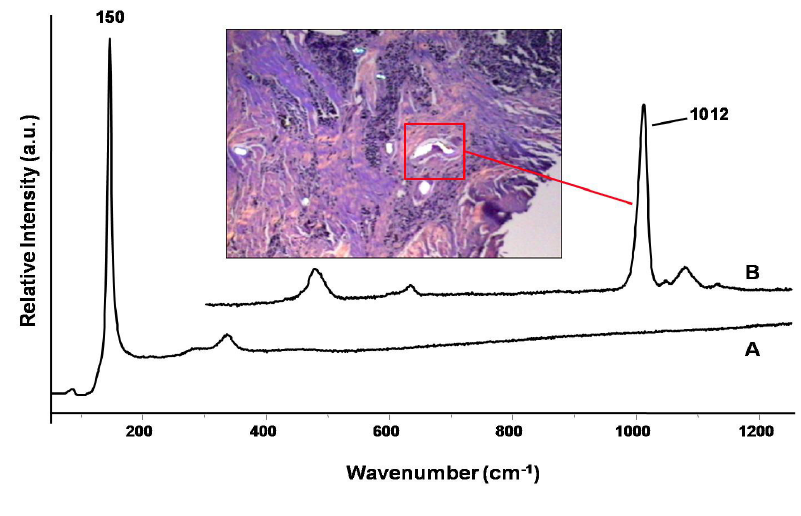
Figure 9. Case 4: Confocal laser Raman microspectroscopy spectra demonstrating the presence of PbO (trace A) and CaSO (trace B) within a tissue 4